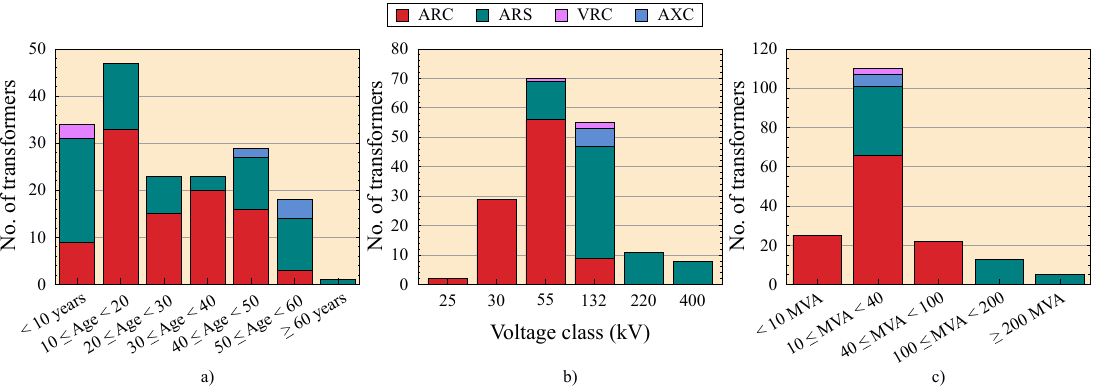
Figure 6. Distribution of power transformers according to ( a ) age, ( b ) voltage class and ( c ) power rating. A, arcing; R, resistor; V, vacuum.